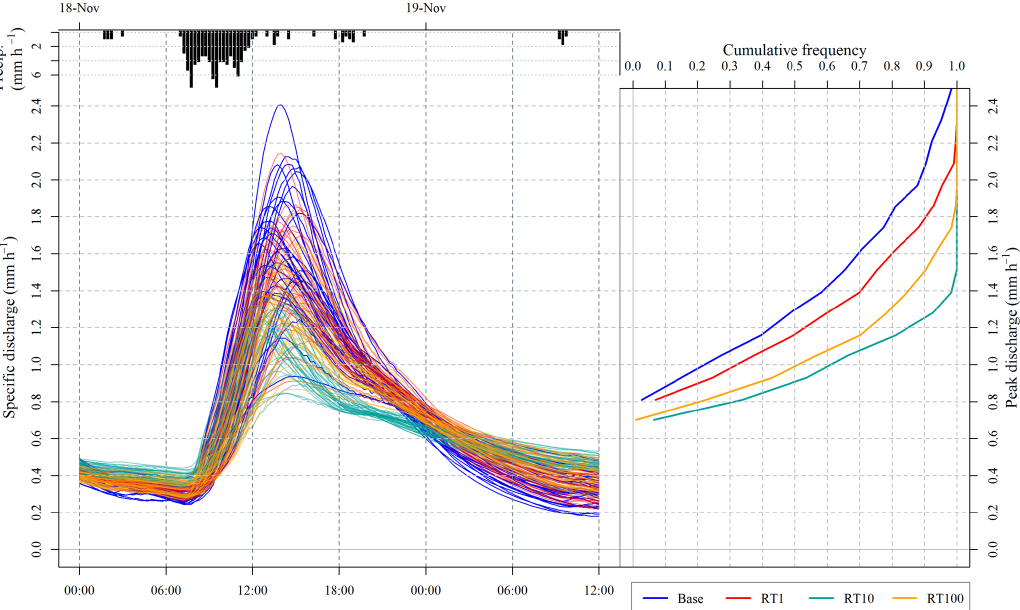
Figure 8. Left: 90th percentile scored baseline and corresponding intervention cases through Storm Barney. Right: CDF of peak discharges for base and intervention